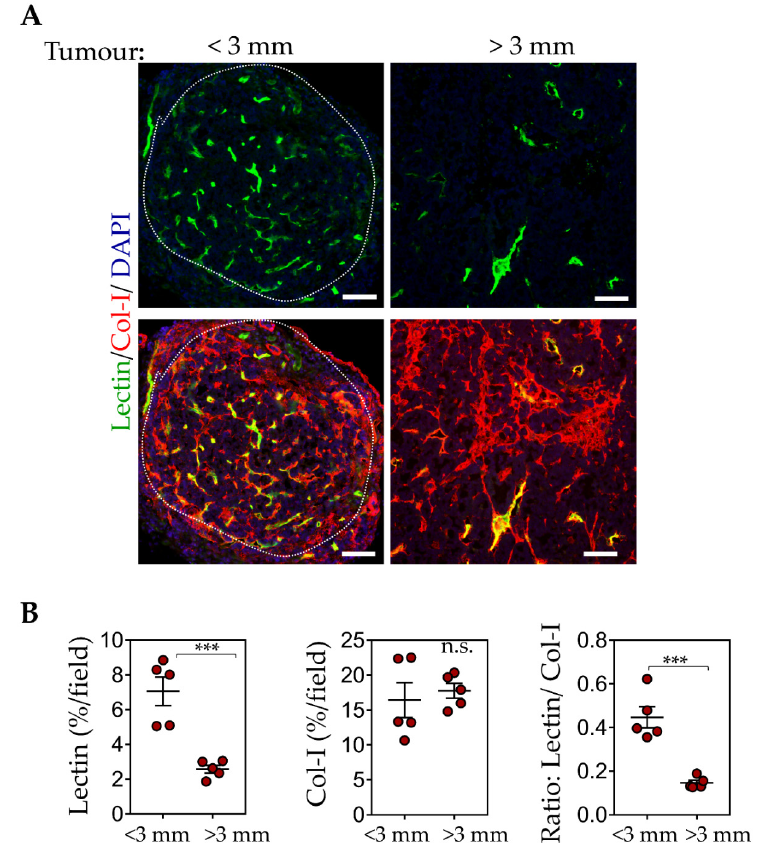
Figure 7. ECM and blood vessel contents in tumours correlate with the effectiveness of CSG and CREKA to deliver IO-NP. ( A ) Lectin + vessels (green) in tumours after RIP1-Tag5 mice received an i.v. injection of FITC-labelled lectin (0.1 µmol). Top: Representative micrographs show % of lectin + vessels in small tumours (diameter < 3 mm) and larger tumours (diameter >3 mm). Bottom: The same micrographs indicating lectin+ area and collagen I expression (red). Scale bars: 100 µm. ( B ) Quantification of % lectin + /tumour (left), % collagen-I+ expression/tumour (middle) and ratio of lectin:collagen-I (right) with mean ± SEM are shown (10 tumours from n = 3 RIP1-Tag5 mice (*** p < 0.001 for Student’s t -test).